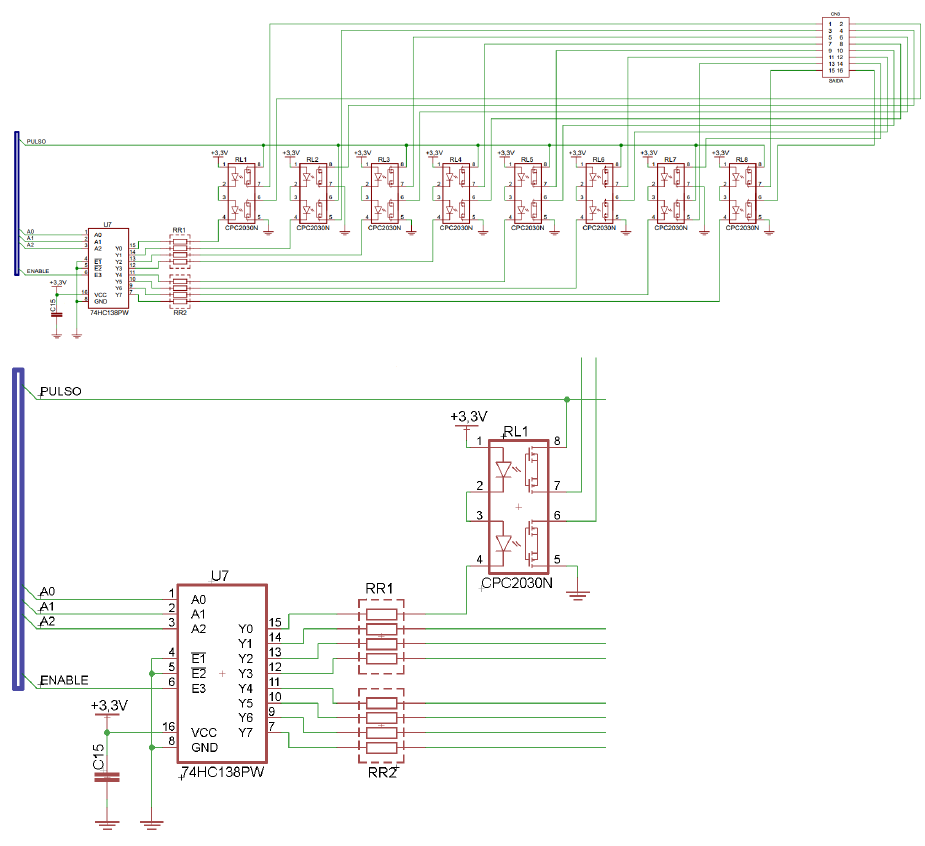
Figure 6. Multiplexing circuit with solid-state